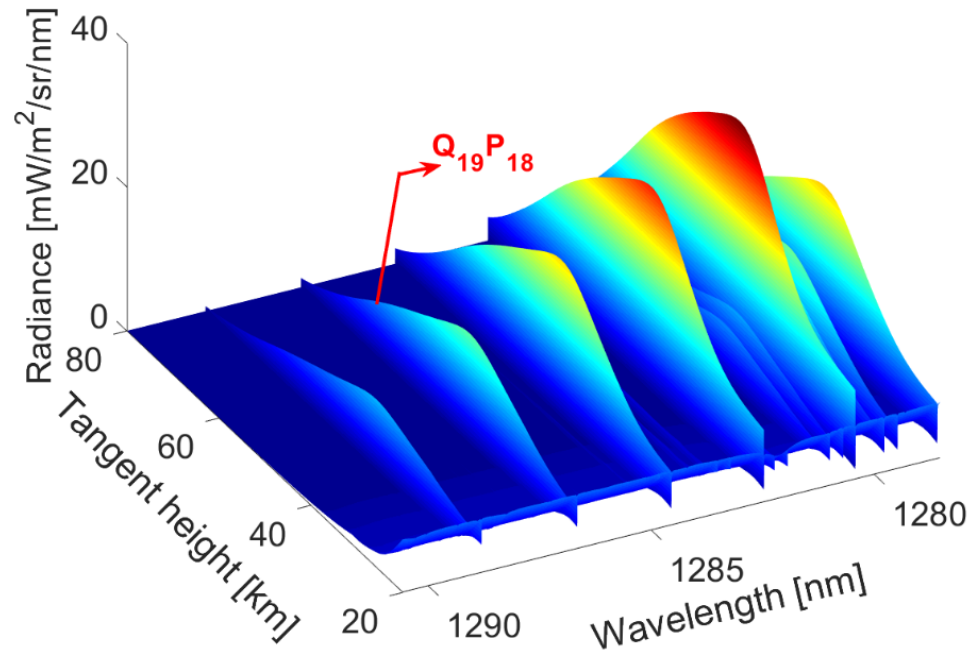
Figure 7. The limb spectral radiance of the O 2 infrared atmospheric band as a function of tangent height.